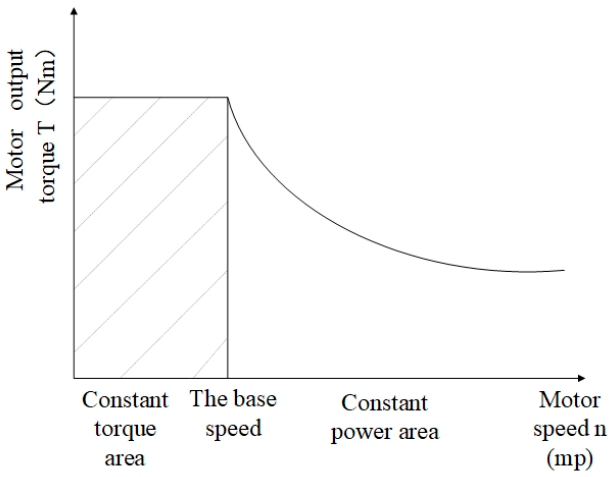
Figure 3. Schematic diagram of constant torque and constant power control process.